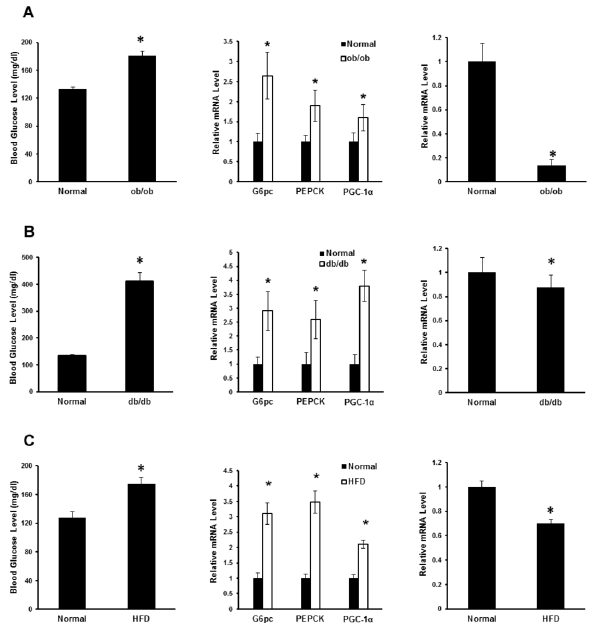
Figure 1. Expression levels of Tff3 in livers of mice with insulin resistance are decreased. (A) Blood glucose were measured (left panel) and mRNA levels of hepatic gluconeogenic genes (middle panel) and Tff3 gene (right panel) in C57BL/6J (control) and ob/ob mice (n=3) were measured by quantitative real-time PCR. (B) Blood glucose were measured (left panel) and mRNA levels of hepatic gluconeogenic genes (middle panel) and Tff3 gene (right panel) in C57BL/6J (control) and db/db mice (n=3) were measured by quantitative real-time PCR. (C) Normal C57BL/6J mice were fed normal chow (control) or fed a high-fat (HF) diet (DIO mice) for 16 weeks (n=3). Blood glucose levels were measured (left panel) and mRNA levels of hepatic gluconeogenic genes (middle panel) and Tff3 gene (right panel) were measured by quantitative real-time PCR. Data are mean ± SEM. *P <